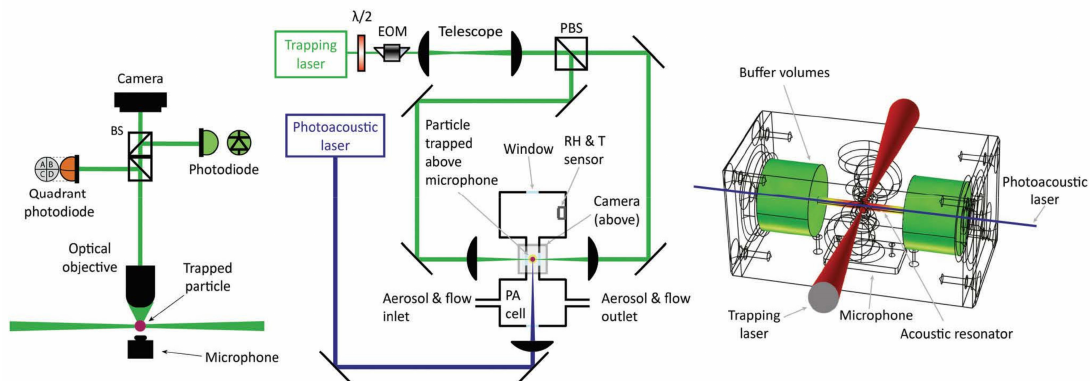
Figure 6. Experimental setup used for single-particle photoacoustic spectroscopy. Left: Side view of the optical setup collecting scattered light from the particle and projecting it onto a quadrant photodiode, a camera, and a photodiode. Center: Top view of the optical table comprised of a trapping laser (green), photoacoustic laser (blue), the PA cell, and a trapped particle (red). The trapping laser is expanded using a telescope and the relative intensities of the two trapping beams are controlled by the electro-optic modulator (EOM). Right: The photoacoustic cell used in these experiments showing the trapping laser (red), the photoacoustic laser (blue), buffer volumes, and a microphone. The color scheme inside the cell represents the acoustic intensity originating from the particle. (Reprinted with permission from [144], under Creative Commons Attribution License. Copyright (2019) The Royal Society of